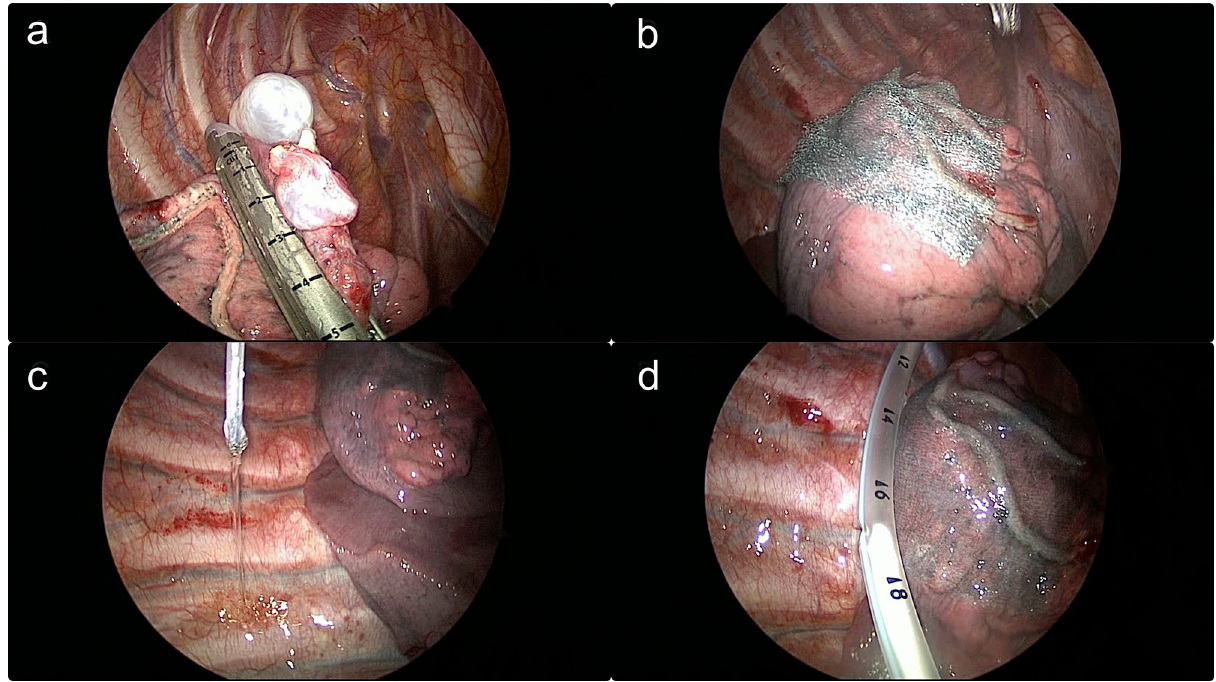
( d ) chest tube placement before lung